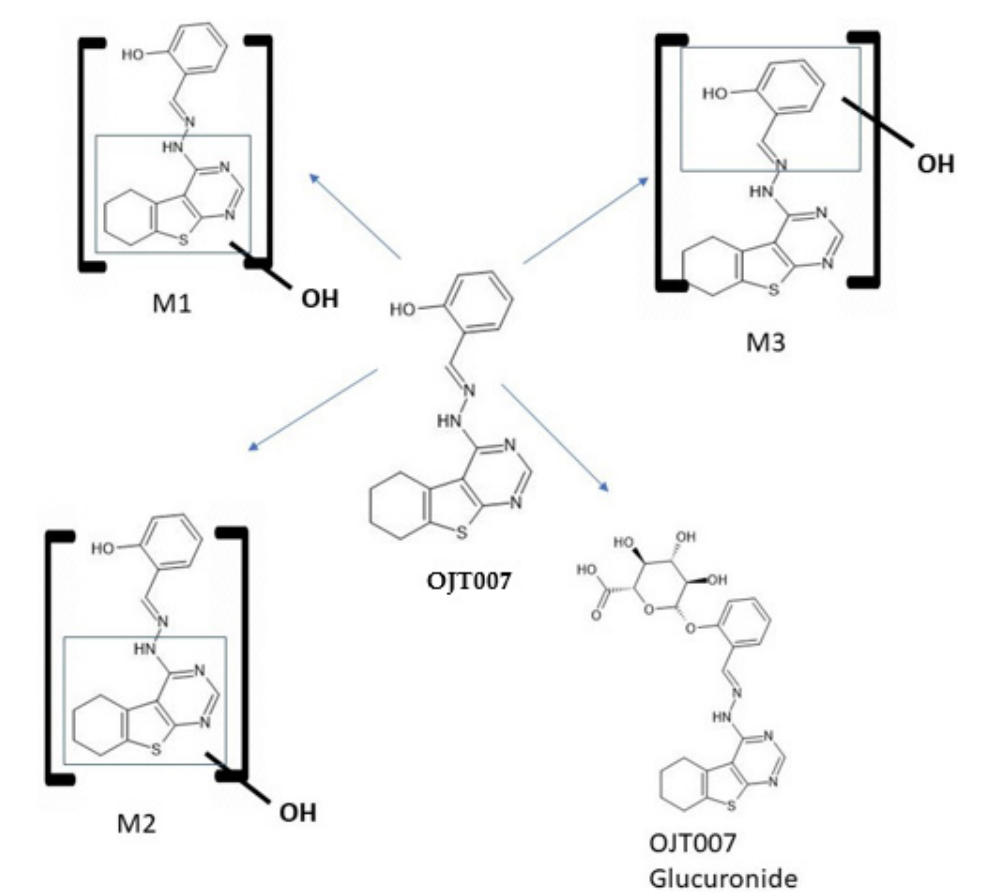
Figure 7. Proposed Metabolic pathway of OJT007 in rat liver microsomes. M1, M2, and M3 represent mono-oxidation metabolite (m/z 341). OJT007 glucuronide represent glucuronidation metabolite (m/z 501).